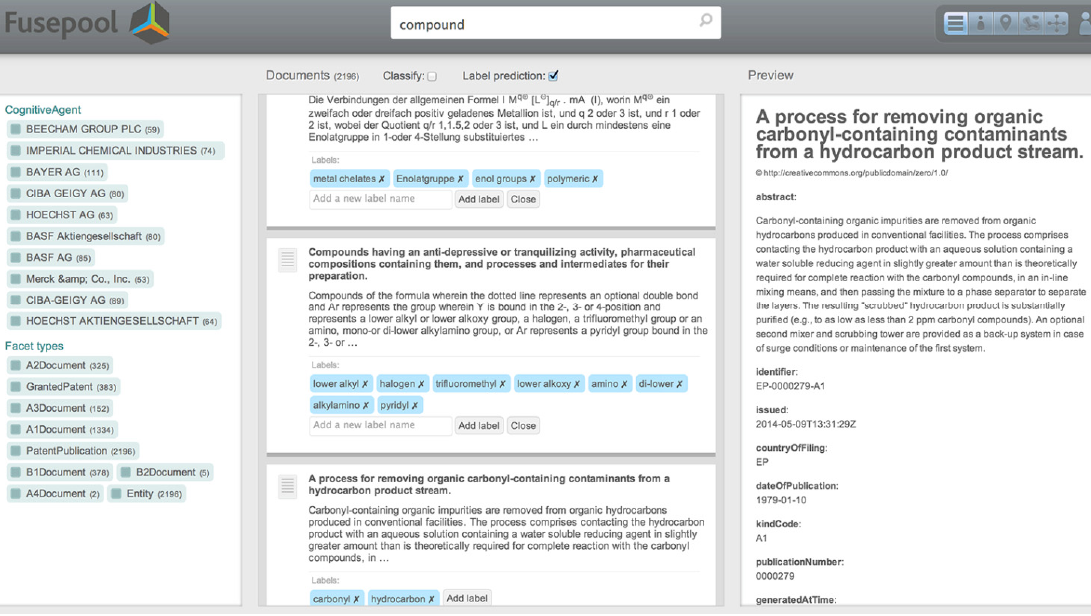
Figure 3. Graphical user interface of the Fusepool Firstswim